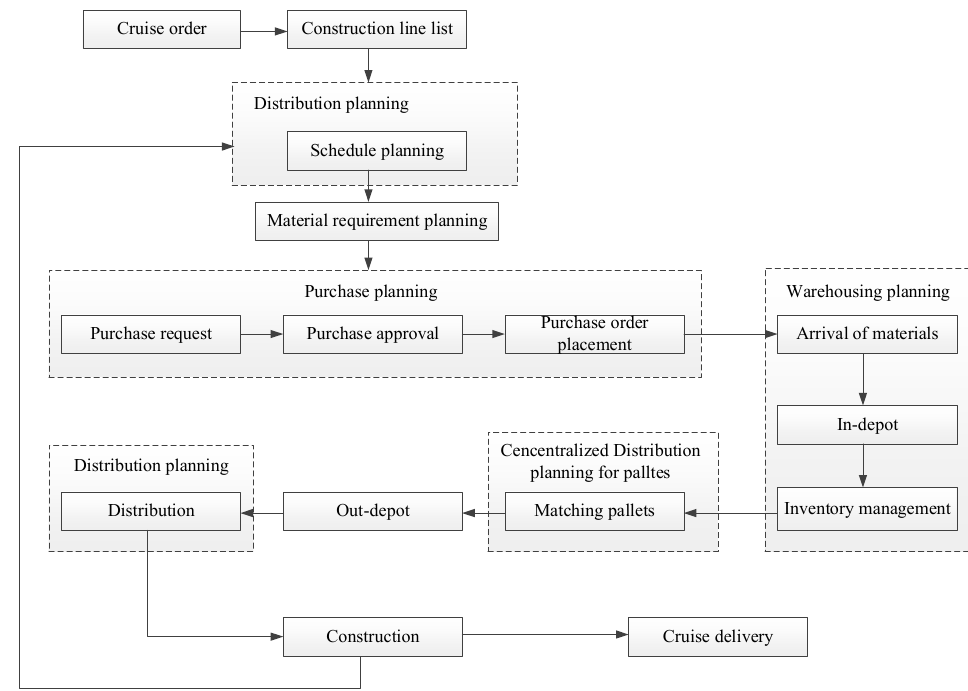
Figure 1. Concentralized distribution logistics planning system in cruise construction.